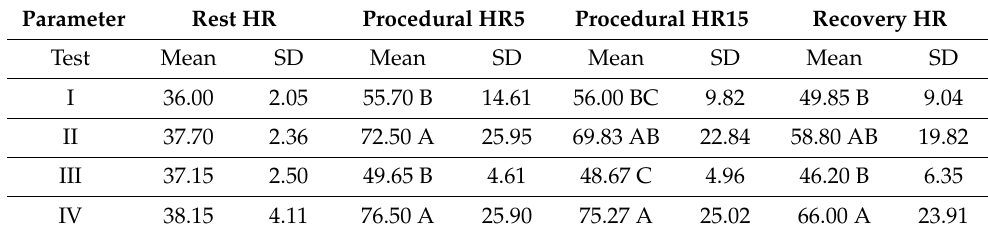
Table 4. HR (heart rate) during consecutive tests.